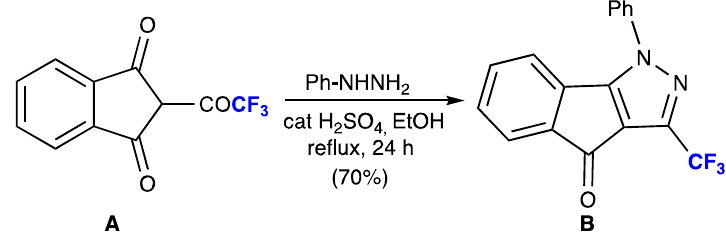
Figure 1. 3-trifluoromethylindenopyrazole synthesis.